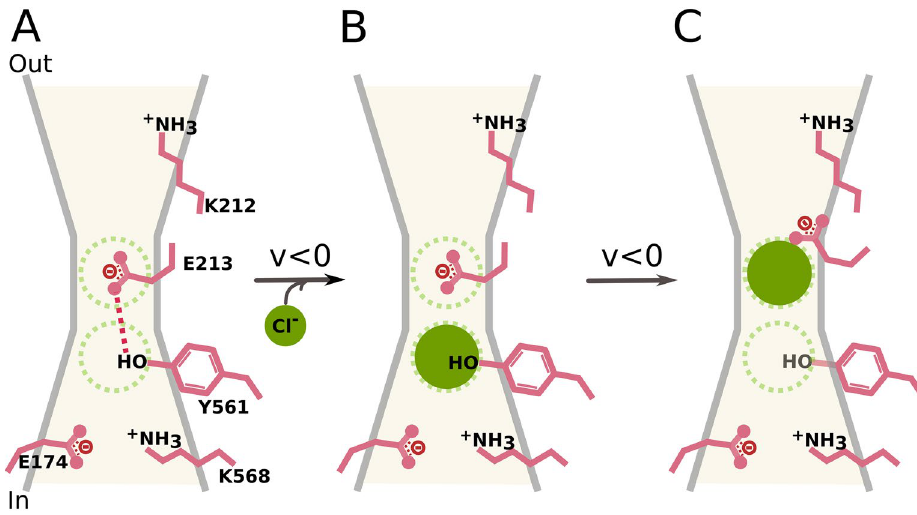
Figure 7. Schematic representation of the electro-steric activation of CLC-2. The Scheme depicts one pore and the side chains of E174, K568, Y561, E213 and K212 lining the pore. The empty pore remains closed by the Y561-E213 gate (A) . Upon a hyperpolarization (V < 0), intracellular Cl − occupies the pore initiating the activation process (B) . The gate is splited by electro-steric repulsion and E213 adopts an outward-facing conformation thus coupling permeation to gating (C)